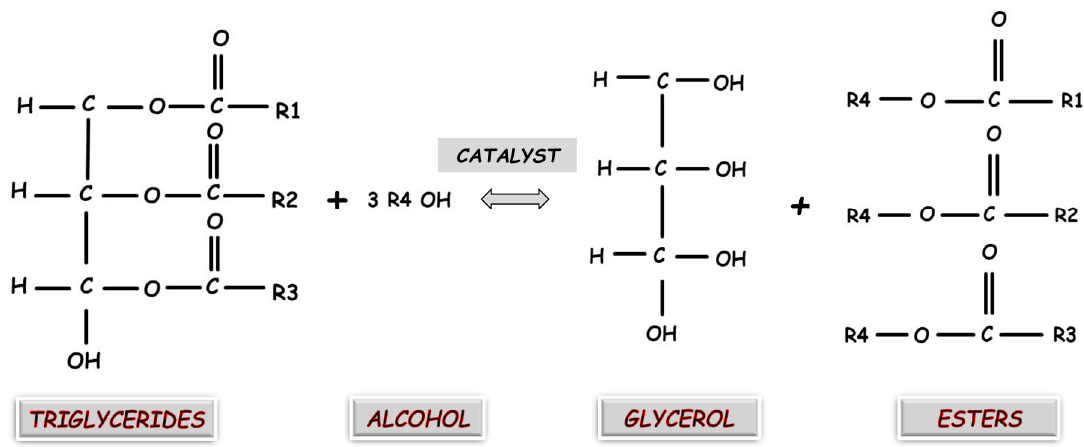
Figure 2. Transesterification of triglycerides to biodiesel (methyl or ethyl–esters mixture) [8] .